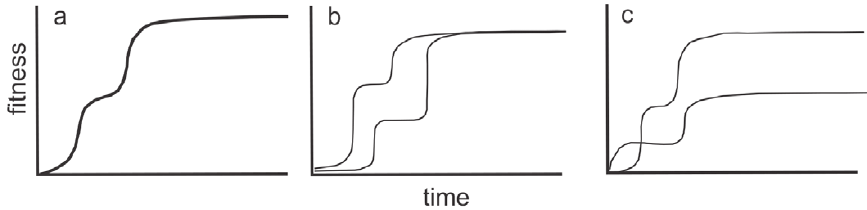
Figure 4 - Schematic evolutionary paths taken by different populations: a) parallel evolution; b) transiently divergent evolution; c) sustained divergent evolution. From Desjardins (2011: